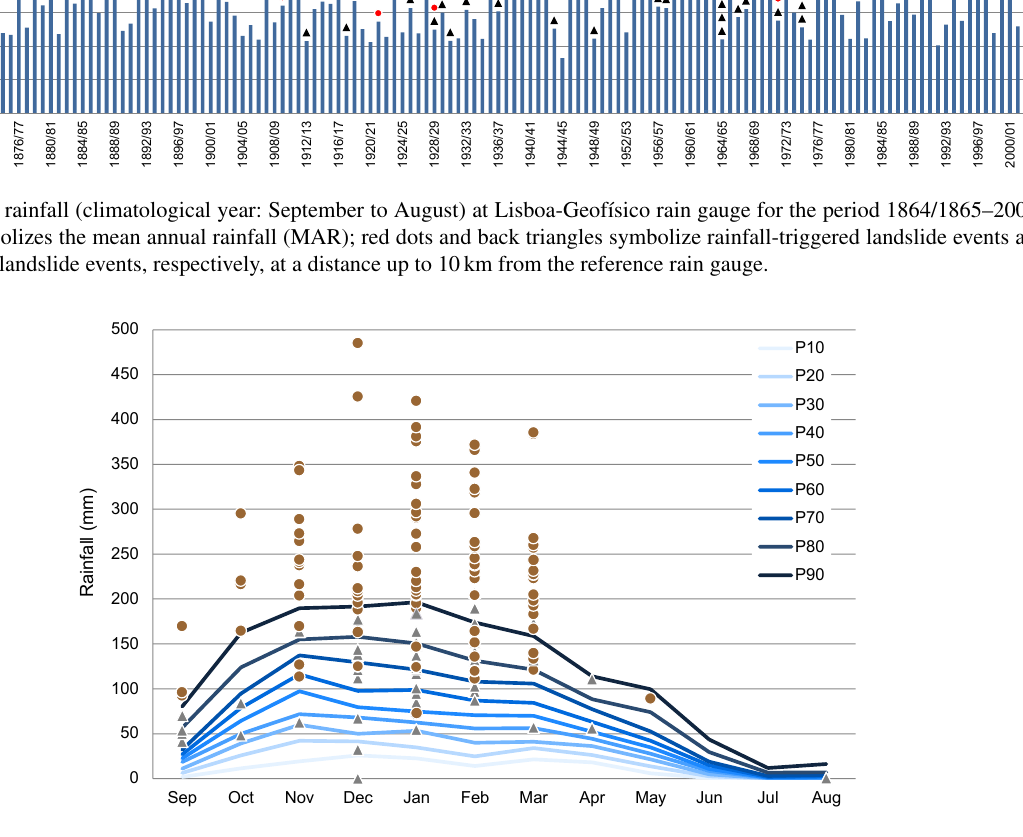
Figure 3. Monthly rainfall percentiles at Lisboa-Geofísico rain gauge for the period 1864/1865–2009/2010. Brown dots and grey triangles symbolize the 30-day cumulated absolute antecedent rainfall for the rainfall-triggered landslide event and for the non-rainfall-triggered landslide event, respectively, at a distance up to 10km from the reference rain